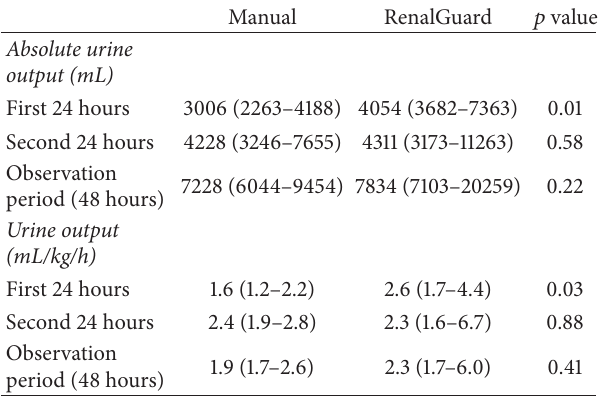
Table 2: Comparison of urine output between groups (median, interquartile